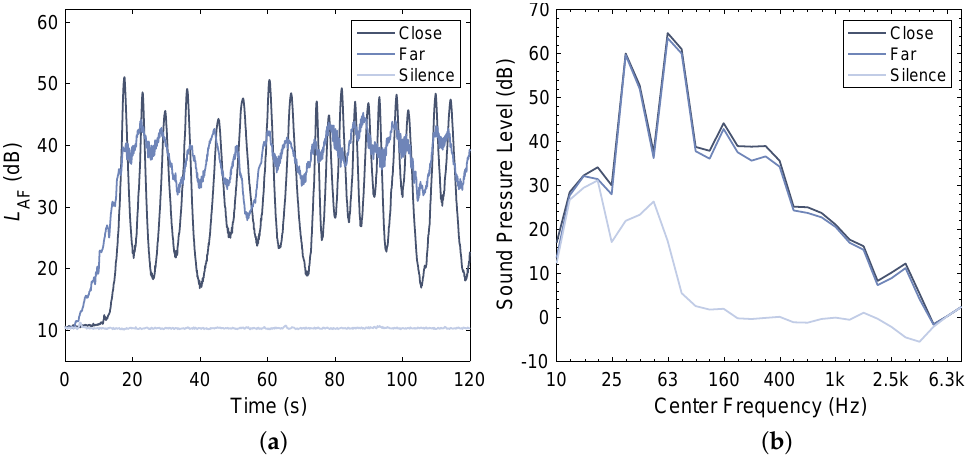
Figure 3. Time structure excerpt ( a ) and third-octave band levels ( b ) of acoustic stimuli recorded at participant position. Table 1. Properties of stimuli, sound pressure levels obtained from recordings at participant